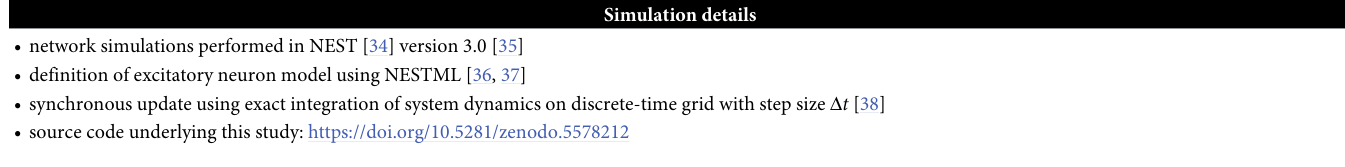
Sequence set I. For an illustration of the learning process and the network dynamics in the prediction (section Sequence learning and prediction) and in the replay mode